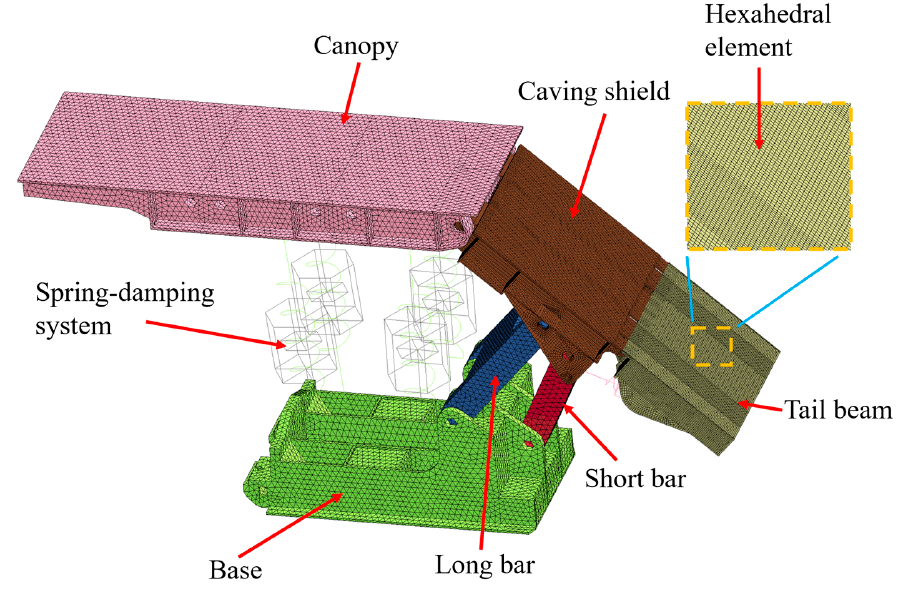
Figure 2. Hydraulic support. Table 1. Material model parameters of metal plate.